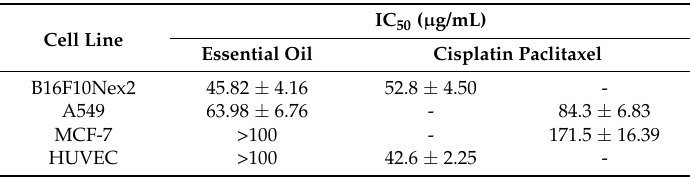
Table 3. IC 50 ( µ g/mL) values to the essential oil from leaves of L. alba and to positive control (cisplatin and paclitaxel) against cell